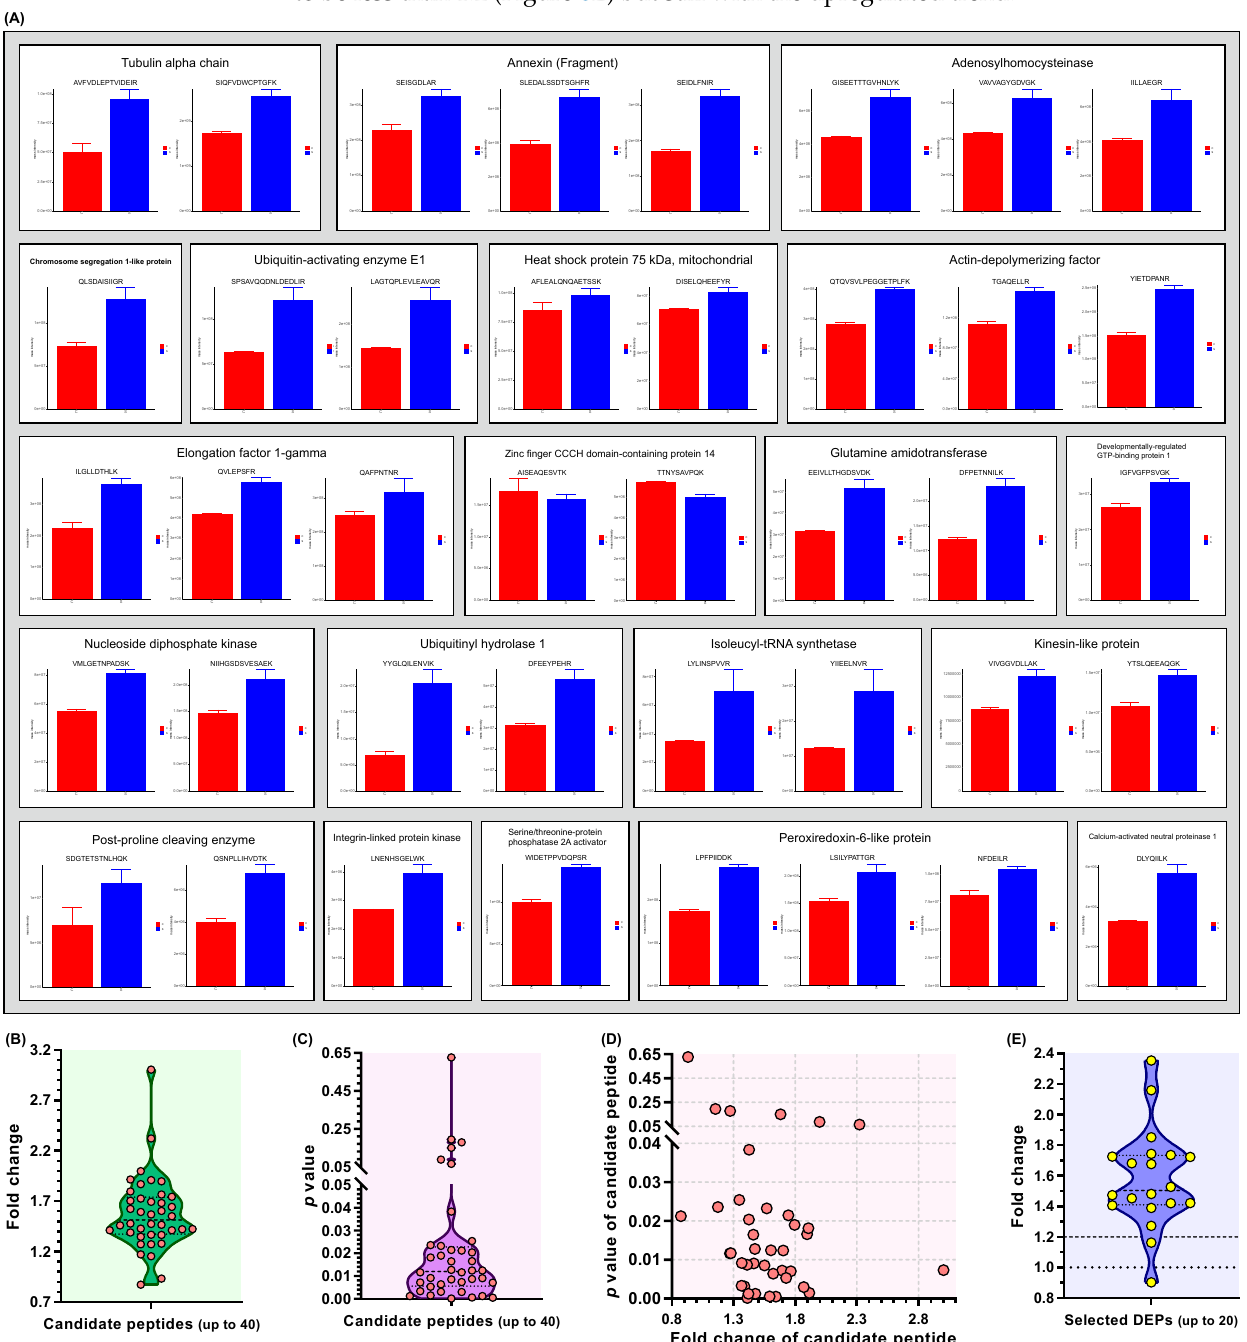
Figure 6. PRM analysis of 20 upregulated DEPs in SVA-infected cells at 12 hpi. Comparison of mass intensities corresponding to 40 candidate peptides between the S and C groups ( A ). Each DEP is involved in one to three candidate peptides, framed by a rectangle. Violin-plot-exhibited distributions of FC ( B ) and p value ( C ) for all 40 candidate peptides. Corresponding relation between FC and p value for each candidate peptide ( D ). Violin-plot-exhibited distribution of FC for all 20 DEPs ( E